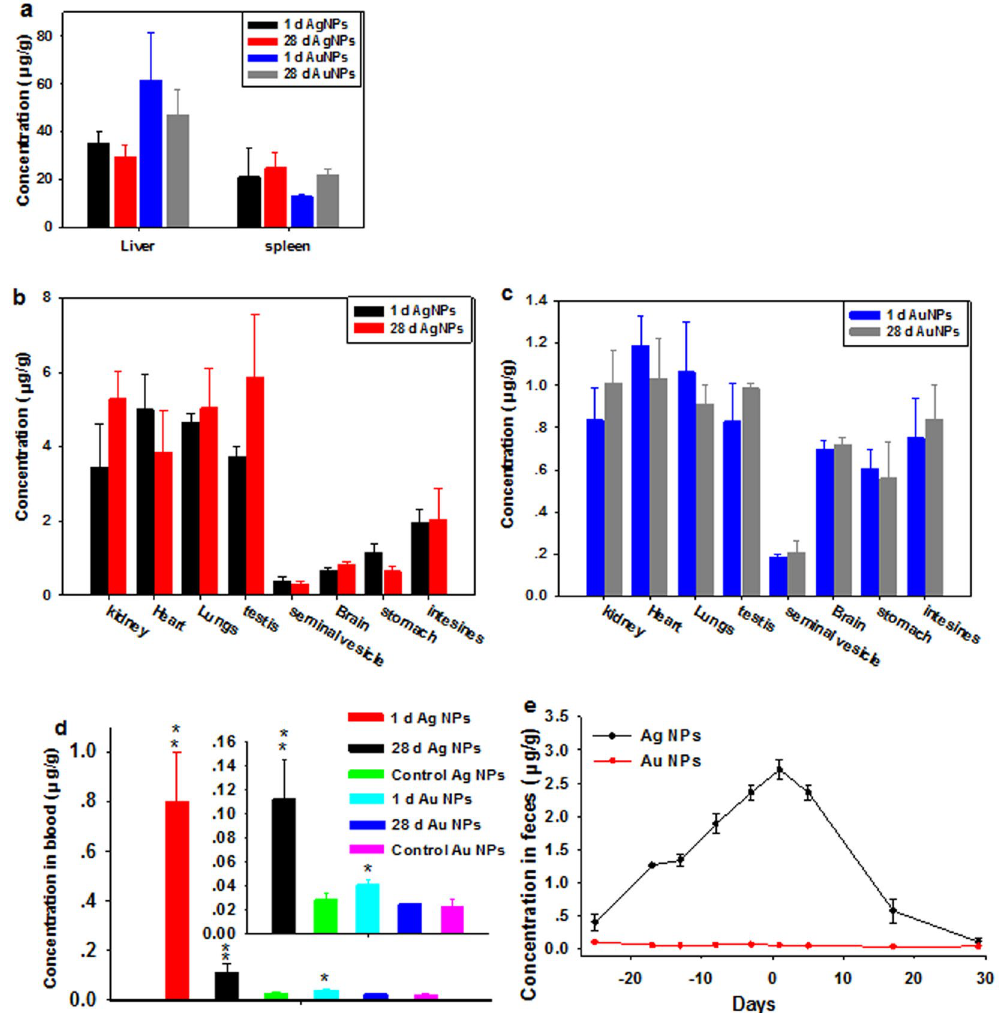
Figure 3. AgNPs or AuNPs levels in animal tissues ( a – c ), blood ( d ) and feces ( e ) as indicators of inorganic NPs biodistribution, circulation and elimination at serial time points. These results show mean and standard deviation, n = 5. a Exhibits the contents of AgNPs or AuNPs in the liver and spleen at both time points, b and c exhibit the contents of AgNPs or AuNPs in the other organs at both time points, respectively. Day − 25 to day 0 are the time interval during which the NPs were